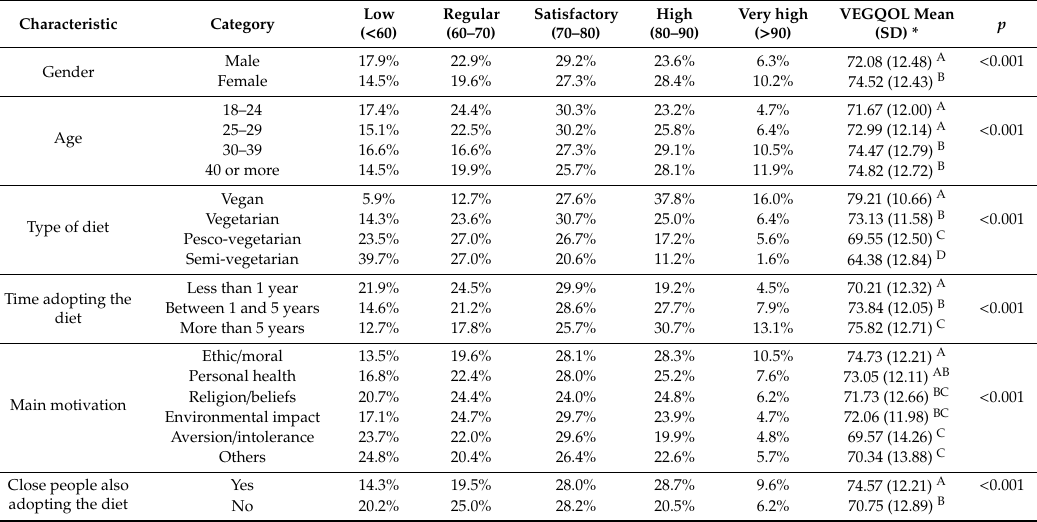
Table 4. Mean quality of life scores results and frequency of score categories of the studied population, by di ff erent characteristics, measured with the VEGQOL n =